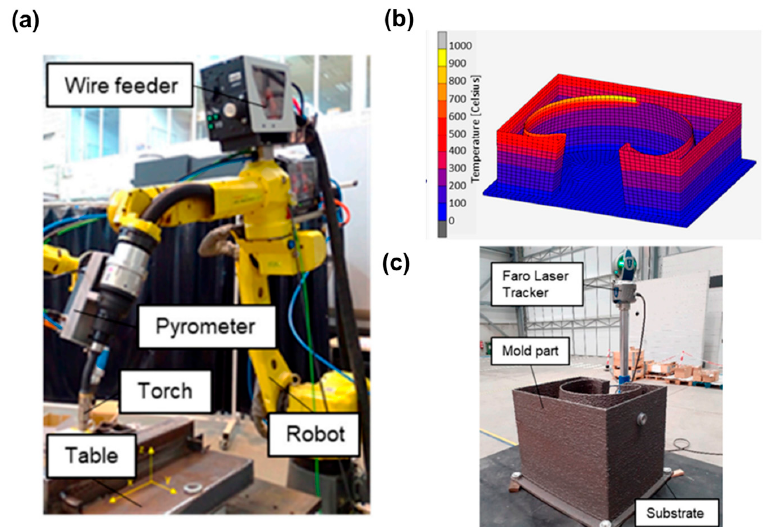
Figure 2. Set ‐ up of the ( a ) robotic system for the manufacture of parts with GMAW ‐ based WAAM, ( b ) model for the temperature estimation, and ( c ) measurement of the deformation in the final part (edited from [18]).